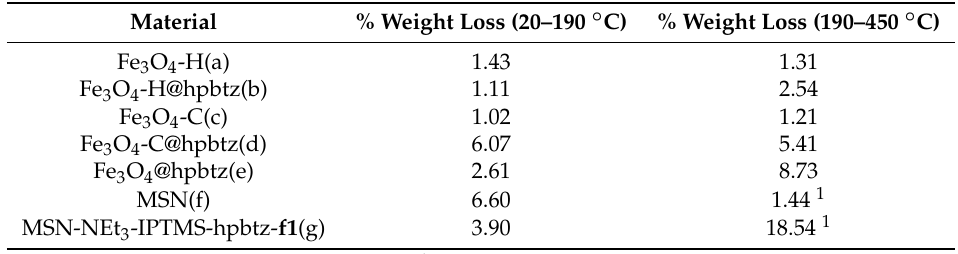
Table 3. Weight loss of the synthesized materials in thermogravimetry experiments.